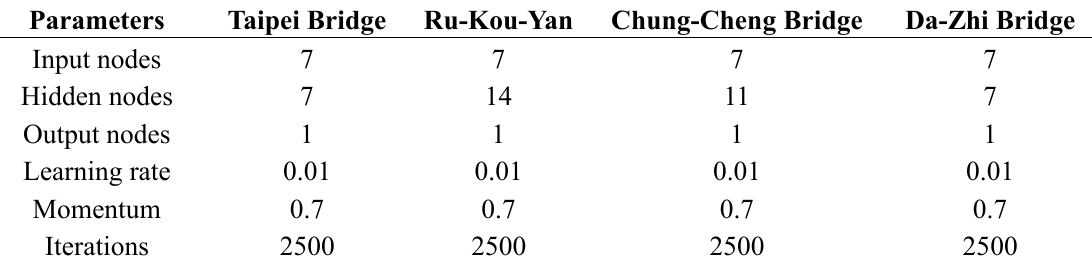
Table 3. The parameters used in the BPNN